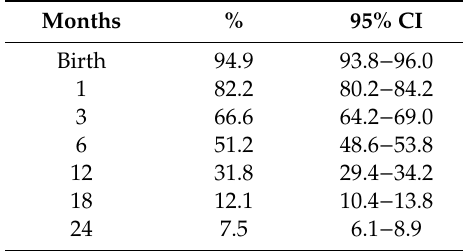
Table 2. Prevalence of breastfeeding up to 24 months (n = 1450).